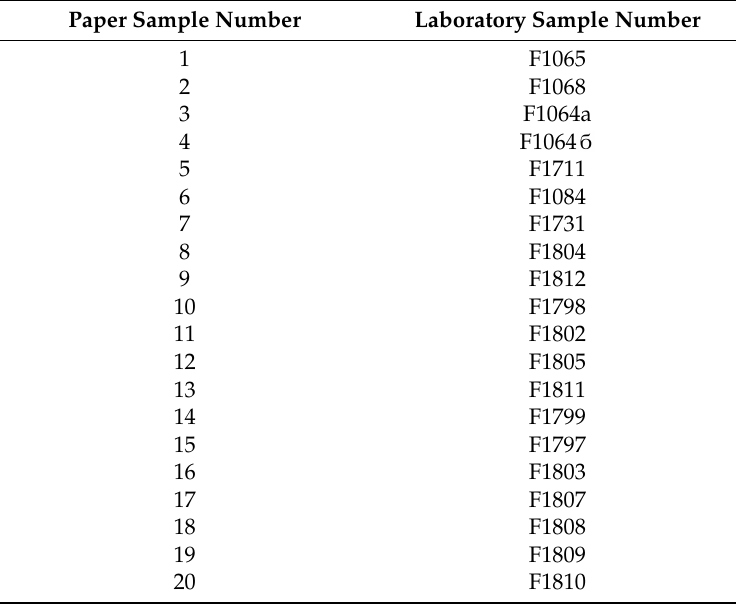
Table A1. Correspondence between the numbering of samples used in the paper and the current laboratory numbering of